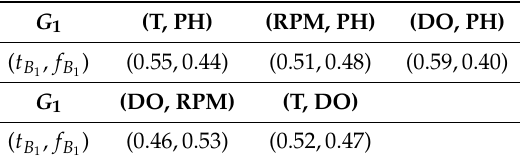
Table 4. Degree of edges in vague graph G 1 .